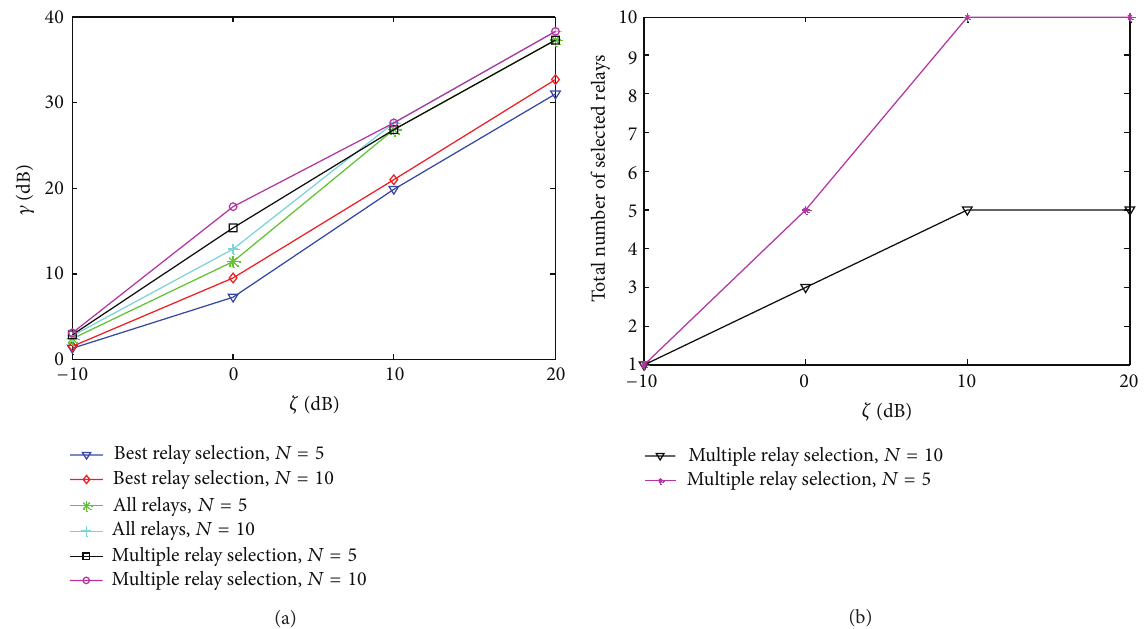
Figure 3: (a) SNR performance versus interference threshold 𝜁 and (b) corresponding number of selected relays.